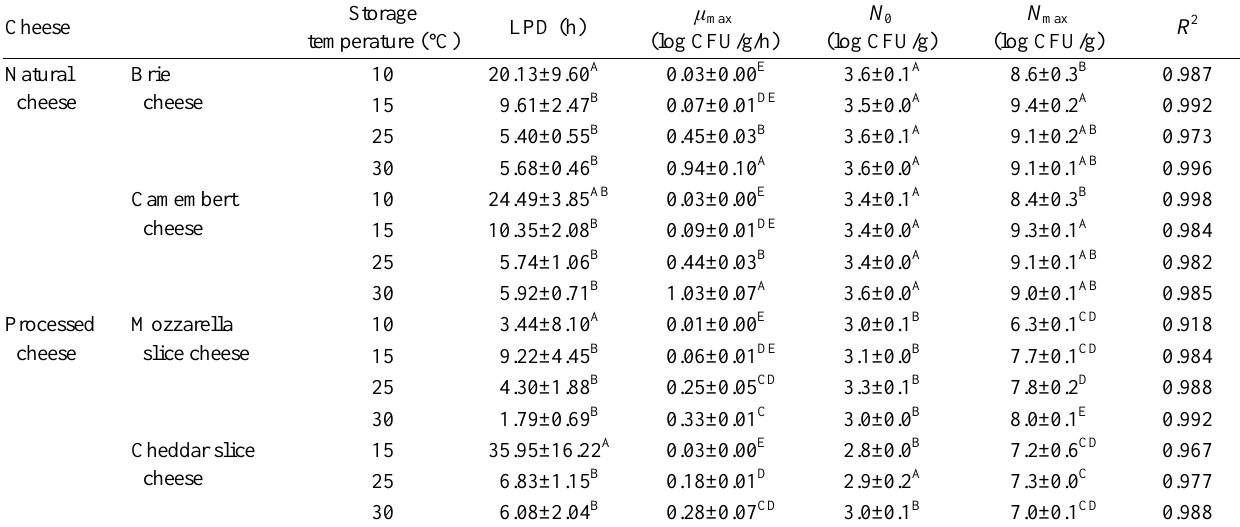
Table 1. Kinetic parameters (mean  standard error) of pathogenic Escherichia coli on natural and processed cheeses, calculated by the Baranyi equation (Baranyi and Roberts, 1994)